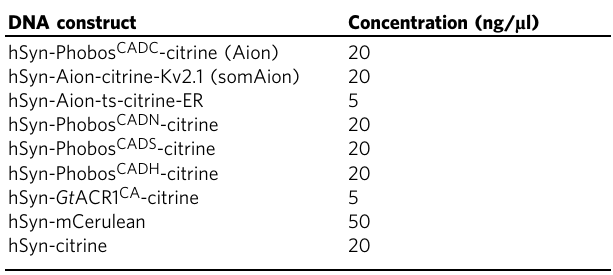
Table 1 List of DNA constructs used for experiments in organotypic hippocampal